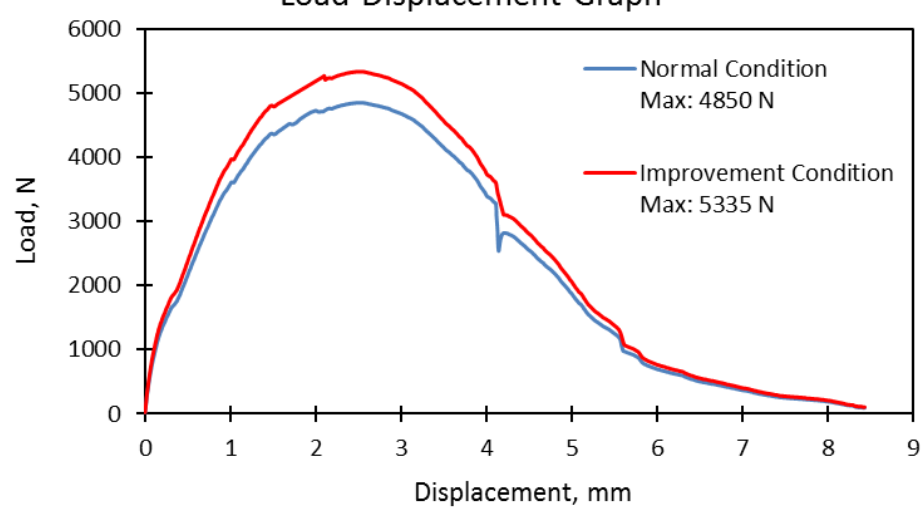
Figure 12. Comparison of normal and improvement conditions by the corresponding load versus displacement.